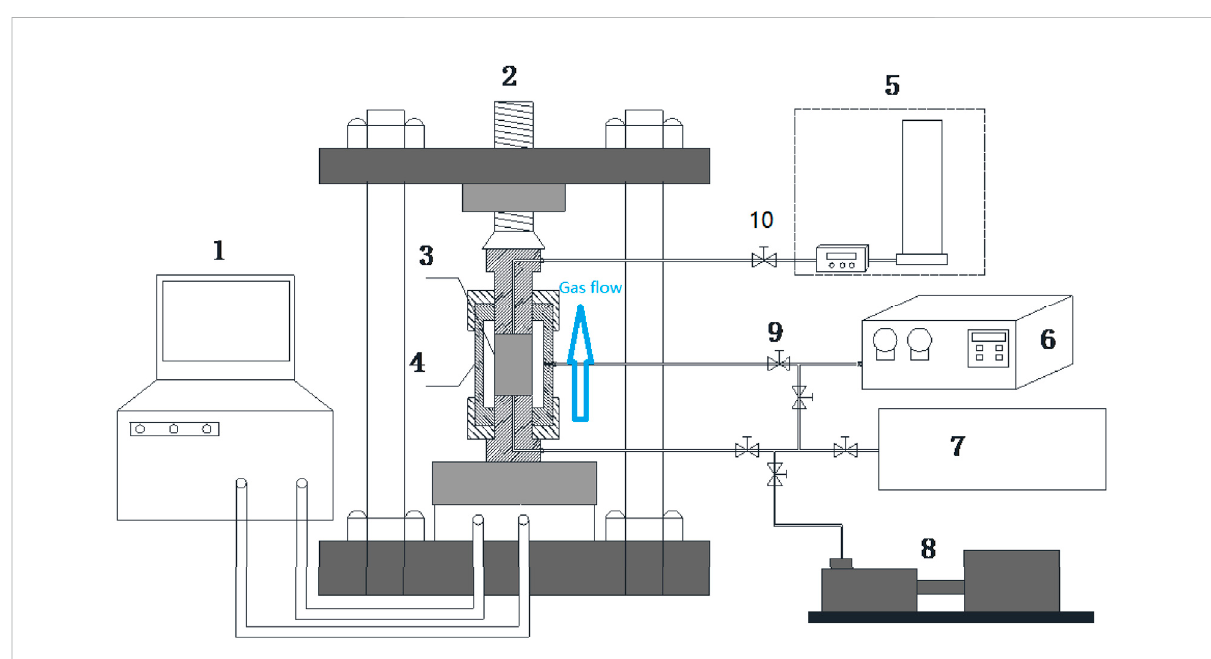
FIGURE 1 Schematic of coal permeability experimental apparatus. 1.Computer; 2. Servo press; 3. Coal sample; 4. Steel cell; 5. Measurement system; 6. Constant fl ux pump; 7. Gas supply; 8. Vacuum pump; 9-10.